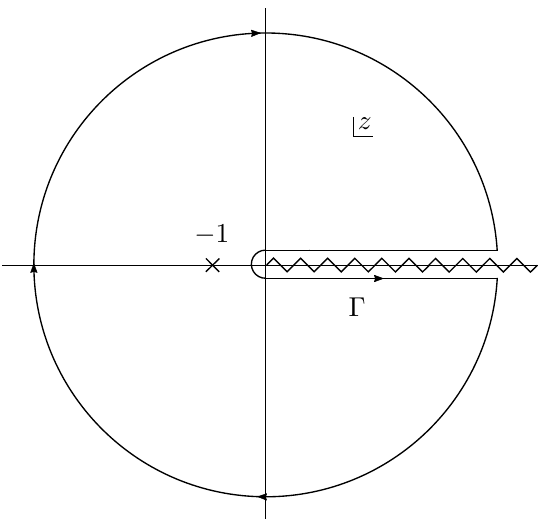
Figure 7 . The integral in (4.7) is carried out along the contour Γ displayed here. We can close the contour at infinity with a big circle since those contributions vanish. The only non-analyticity in the integration region is the simple pole at z = − 1 for which we obtain the